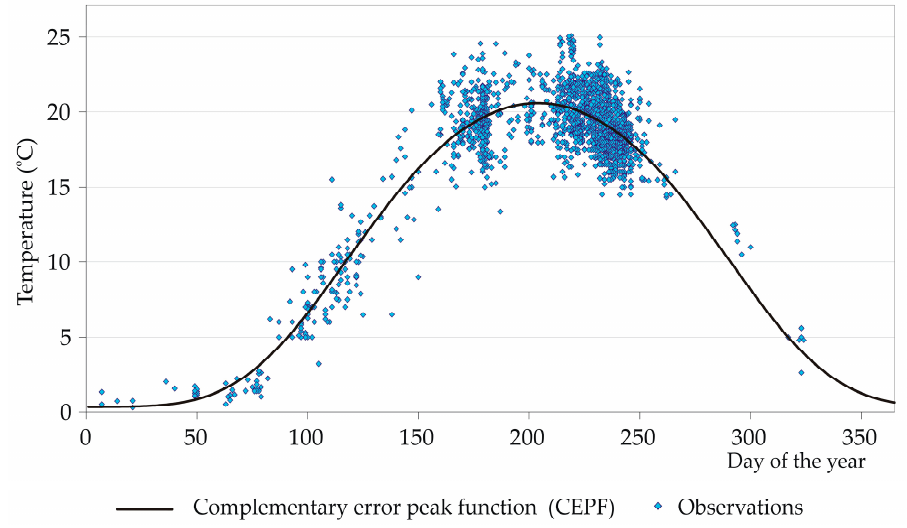
Figure 7. The in situ measurements of the water temperature (average in the layer 0–3 m) in Polish lakes in the 1951–1968 period, with linear interpolation to calculate the daily temperature.